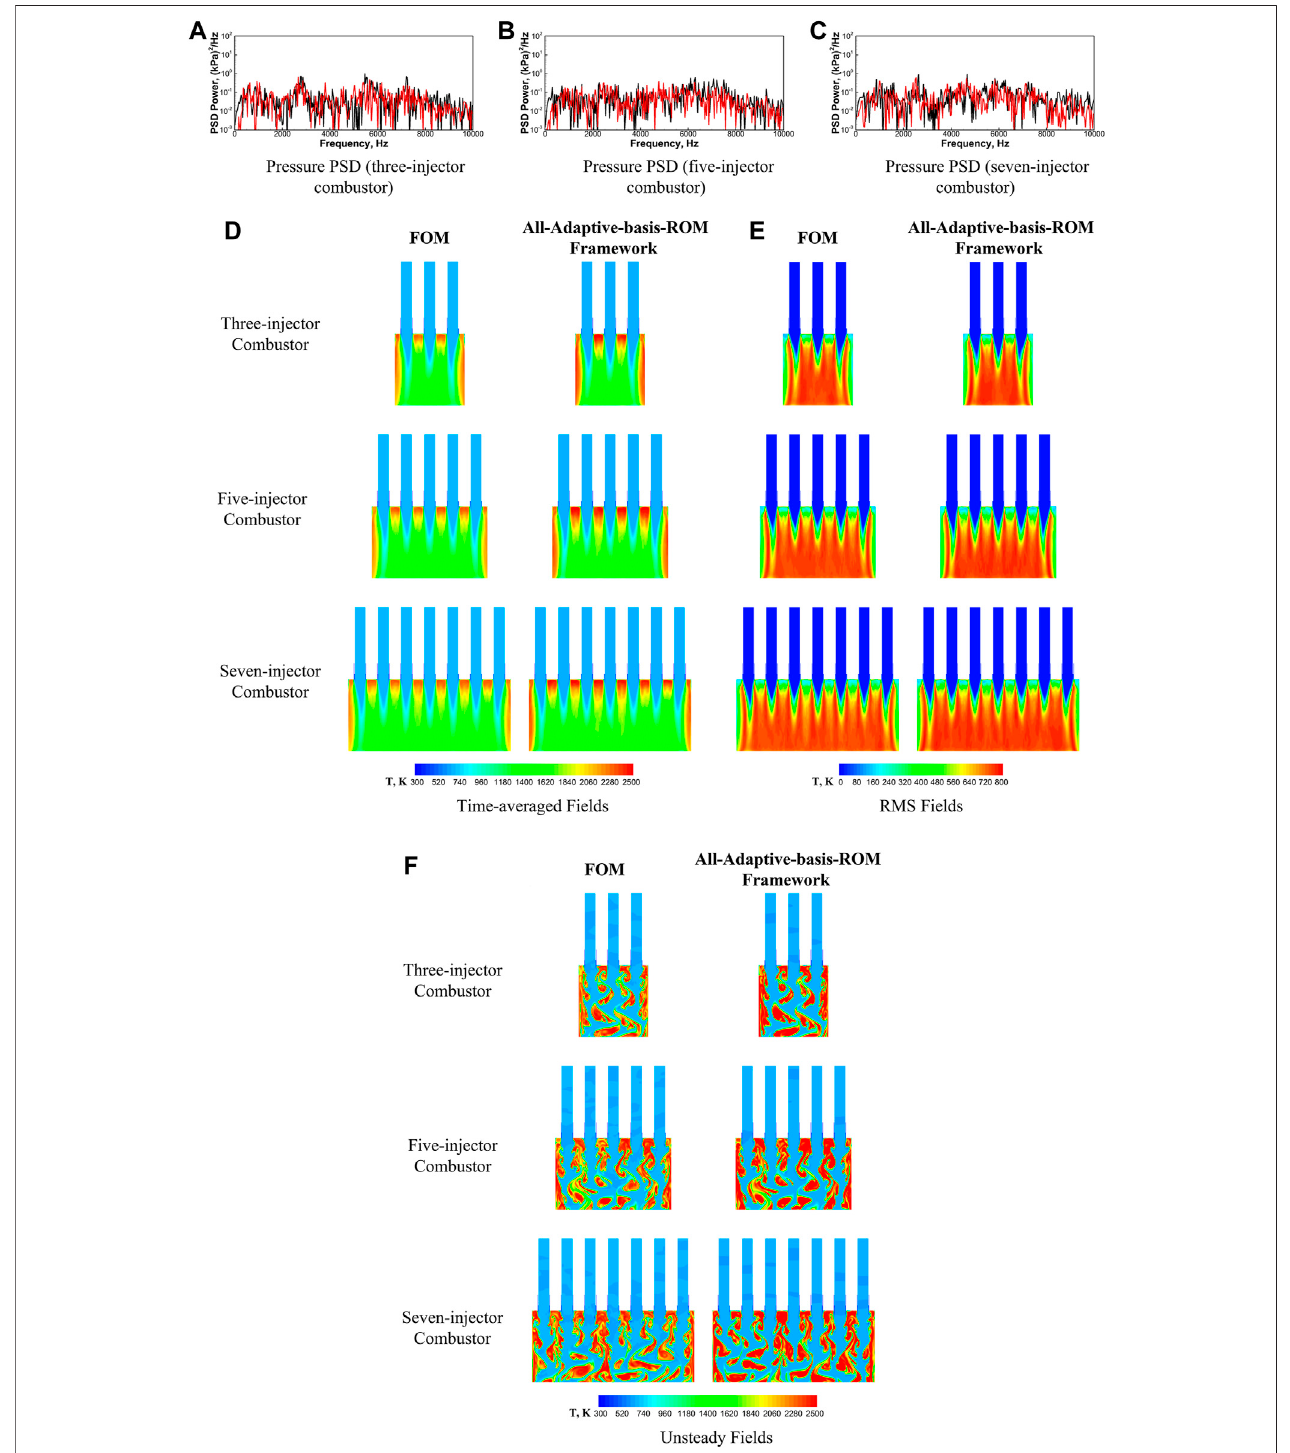
FIGURE10| ComparisonsofpressurePSDs (A – C) measured at ( x , y )= (0,0)in Figure8 with differentmodels (all-adaptive-basis-ROM (Red)frameworkvs. FOM (Black), (D) time-averaged, (E) RMS, and (F) unsteady temperature fi elds with different models (all-adaptive-basis-ROM framework vs. FOM) used in the framework for the three-injector (top), fi ve-injector (middle), and seven-injector (bottom) con fi gurations for the 2D-planar multi-injector model rocket combustor.